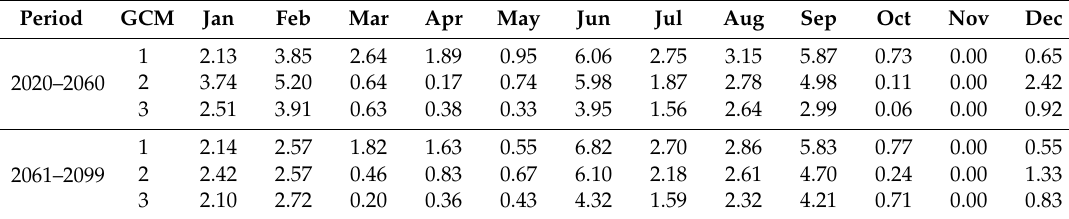
Table 12. RCP 4.5 Future Water Stress Index (WSI) estimations.